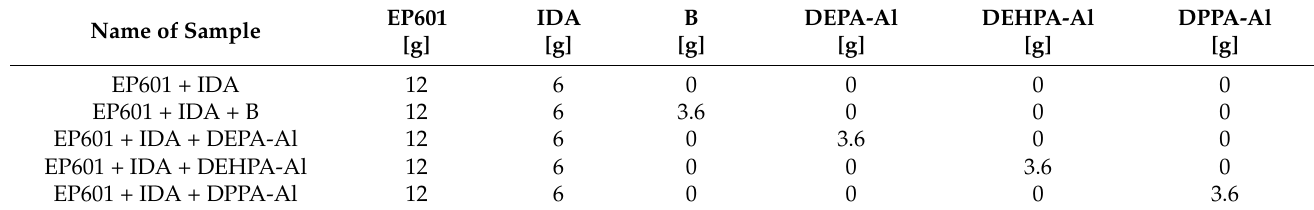
Table 1. Amounts of chemicals *.